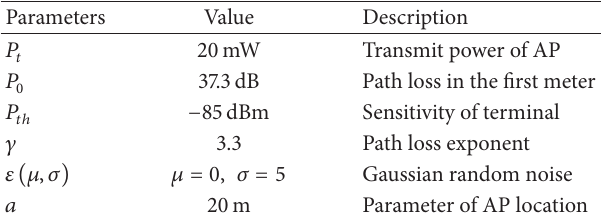
Table 2: Simulation